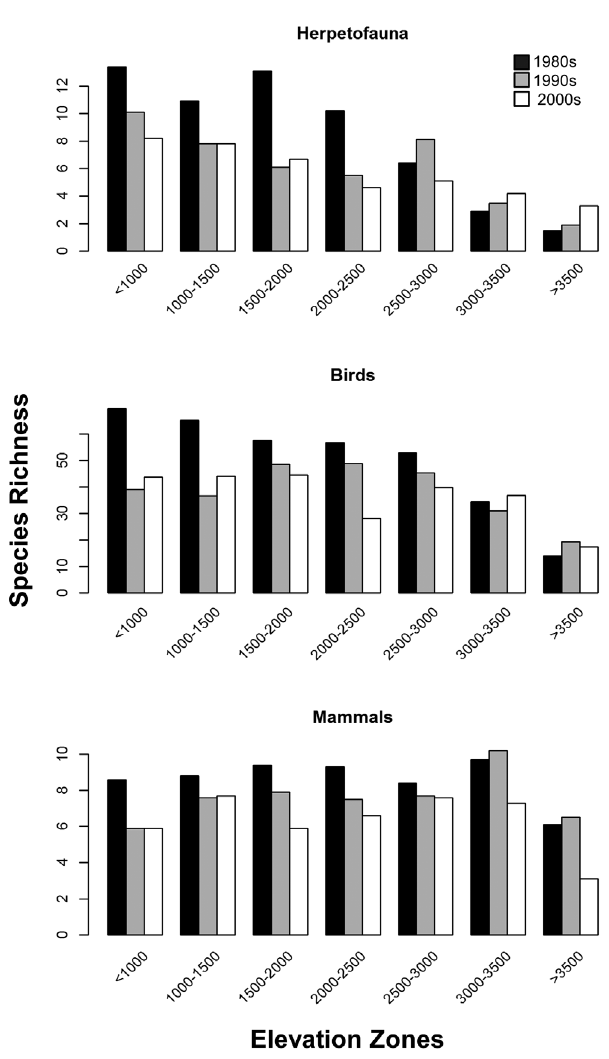
Figure 5. Estimated changes in species richness of birds, mammals, and herpetofauna through time. Species richness values were estimated for each 500 m elevation